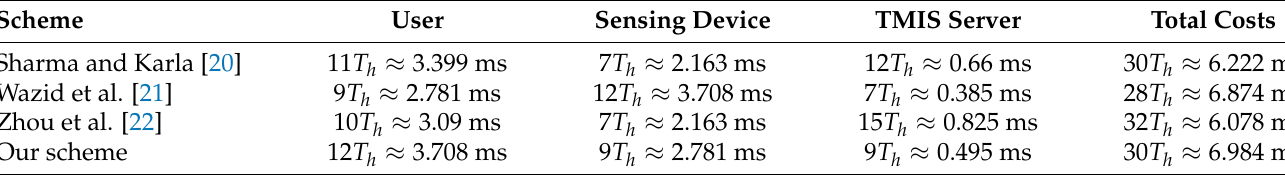
Table 7. A computation cost